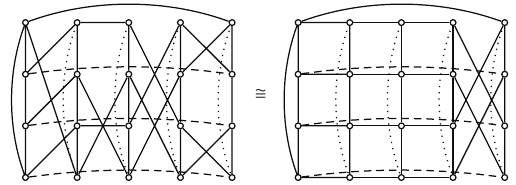
Figure 1: Size representation of Cartesian graph bundles over cycle 𝐶 4 .